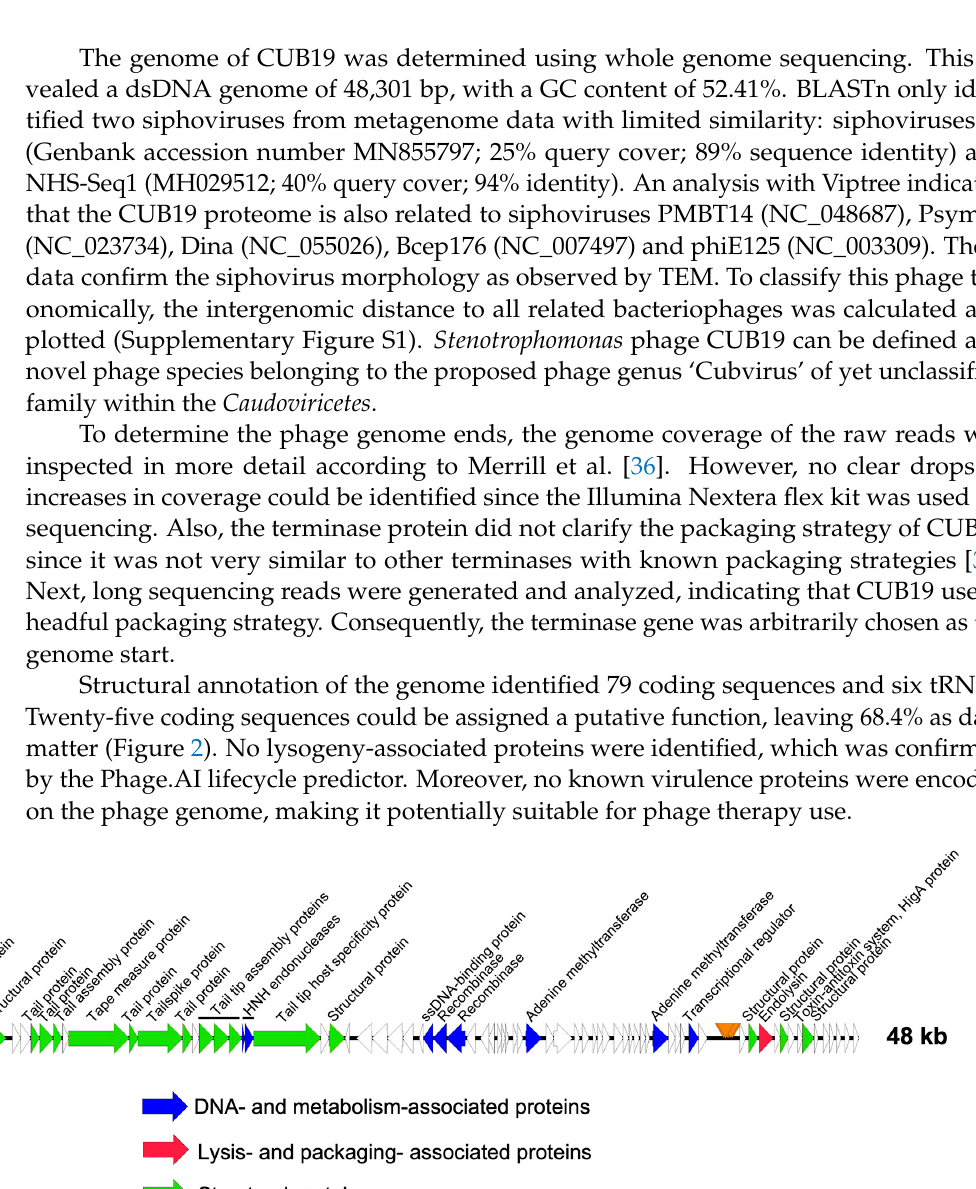
Table 1. Structural proteins of CUB19. Sixteen proteins were identified by ESI ‐ LC ‐ MS/MS as being part of the CUB19 virion. For every protein, the molecular weight (MW), the unique peptide count and the protein sequence coverage is provided.